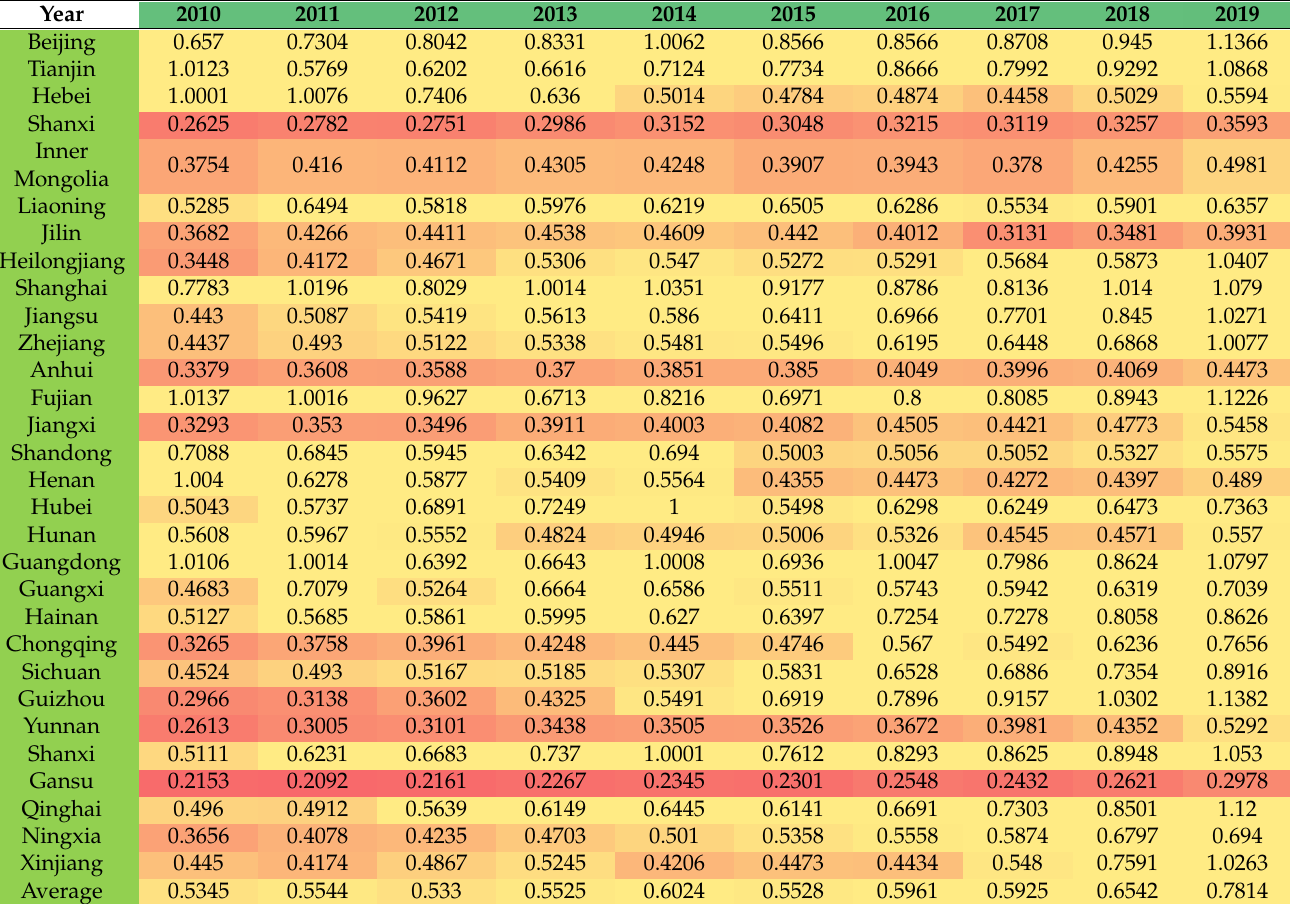
Table 2. The results of the measurement of agricultural production efficiency in different regions of China from 2010 to